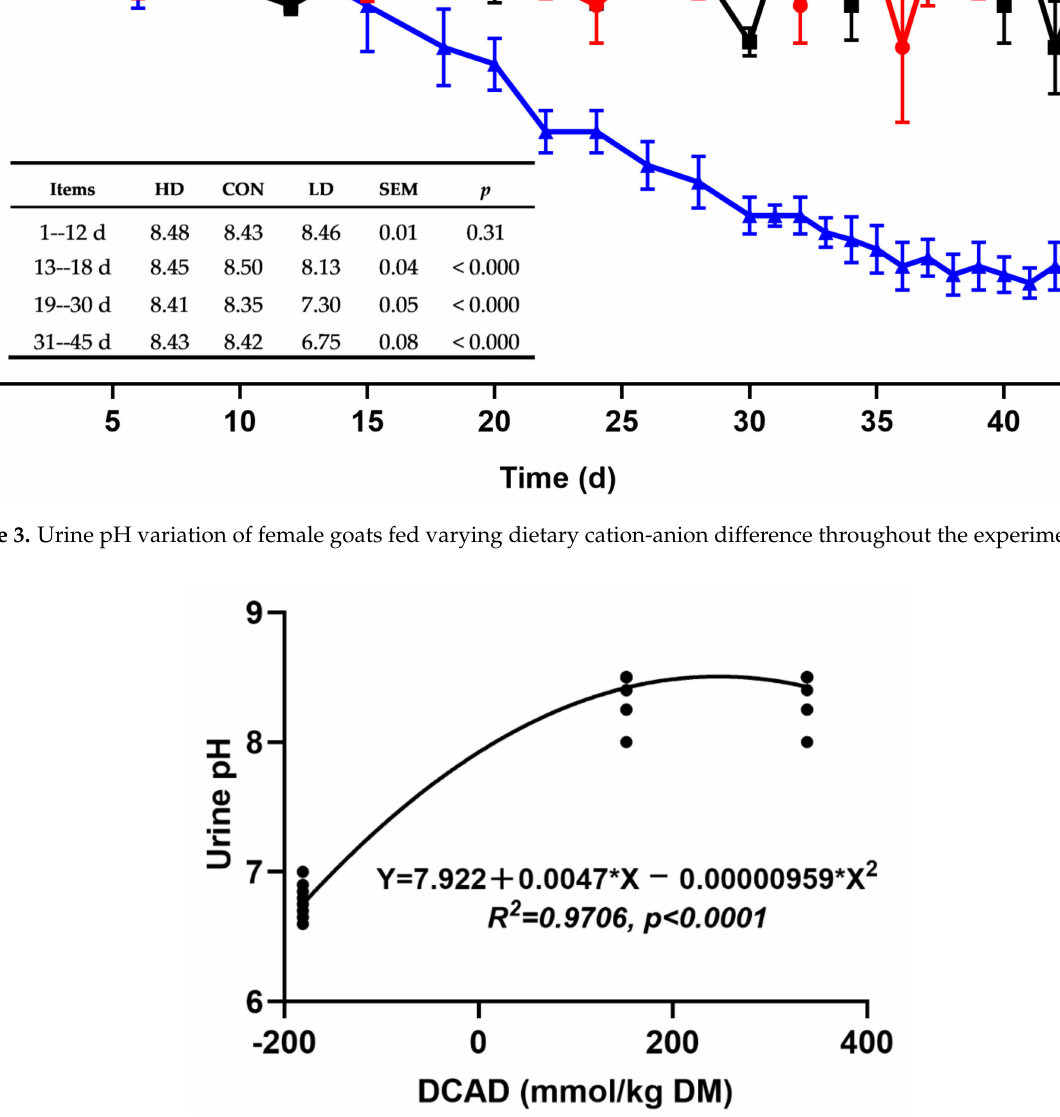
Figure 4. Association between urine pH and varying dietary cation-anion difference of female goats within the trial